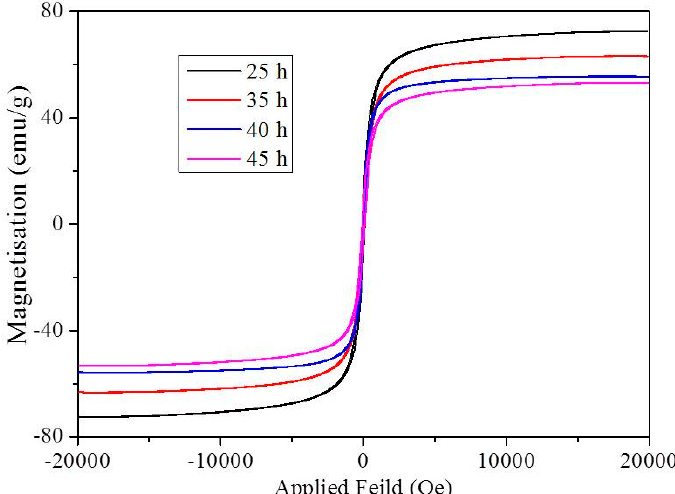
Figure 4. Magnetic hysteresis curves obtained for GO-Fe nanocomposite with a 50:50 composition milled for 25, 35, 40, and 45 milled for 25, 35, 40, and 45 h.